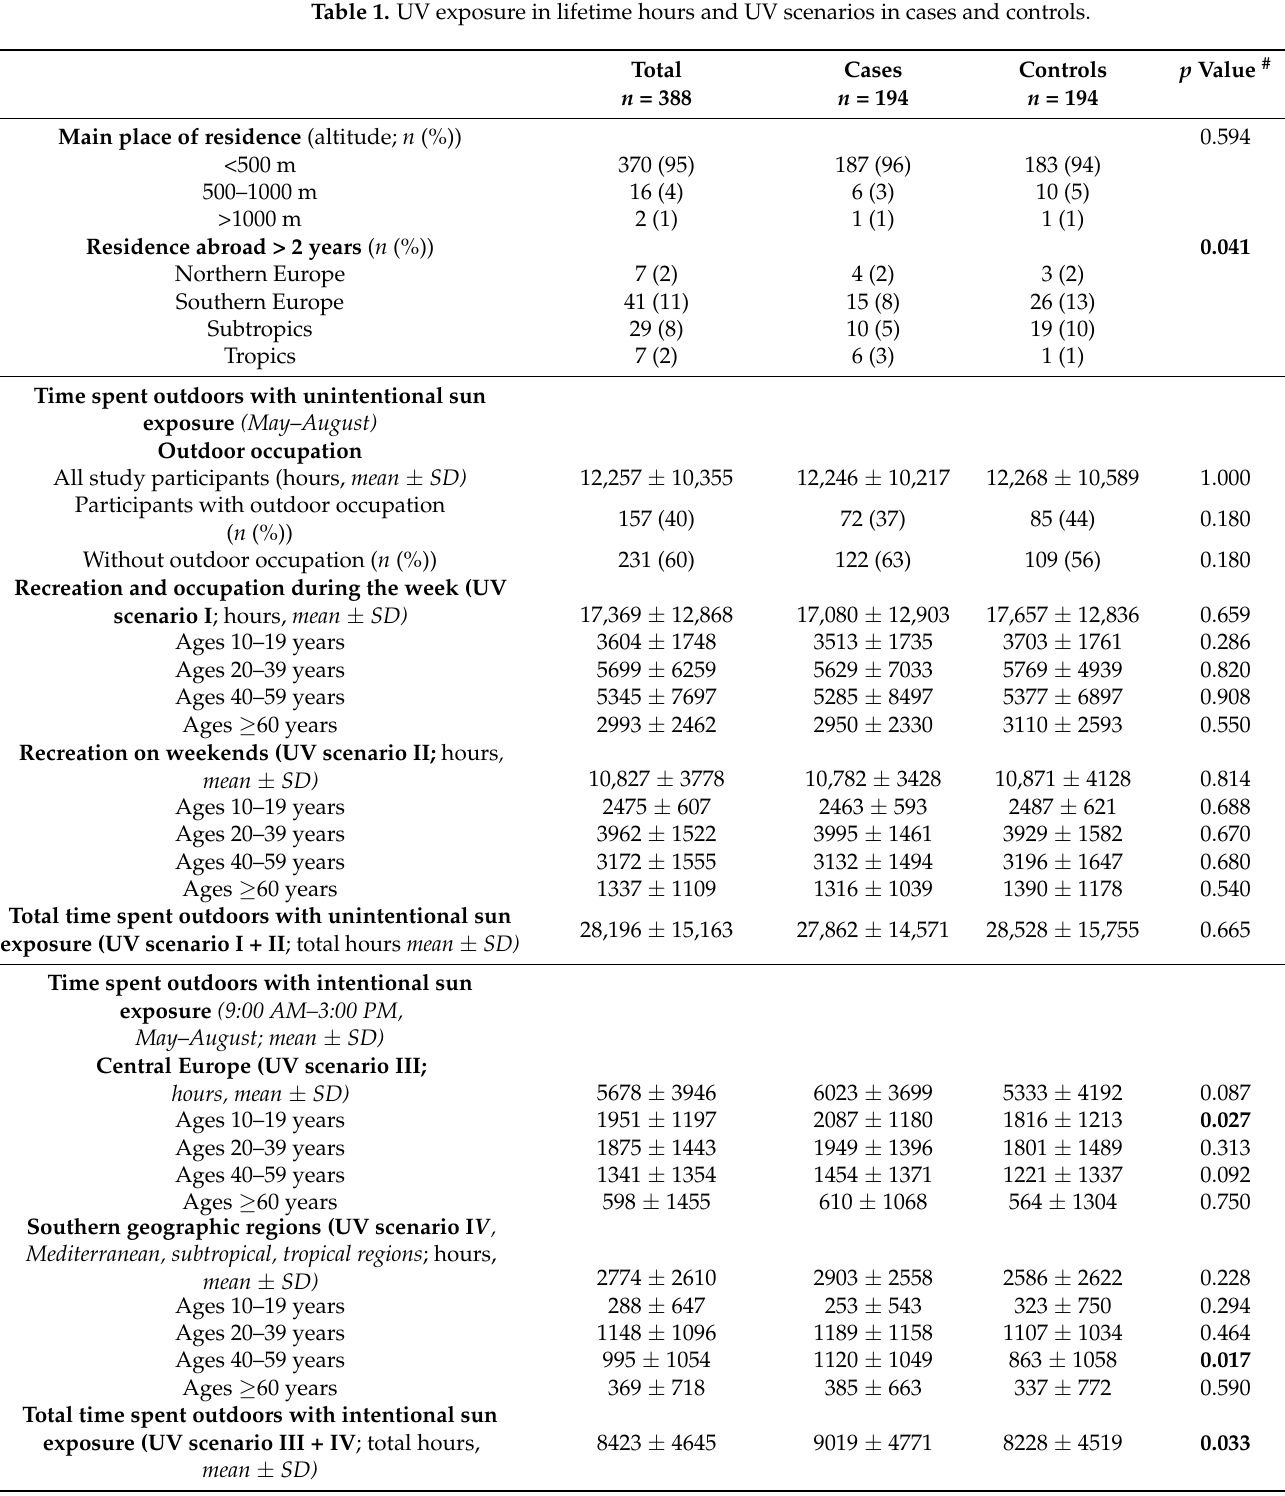
Table 1. UV exposure in lifetime hours and UV scenarios in cases and